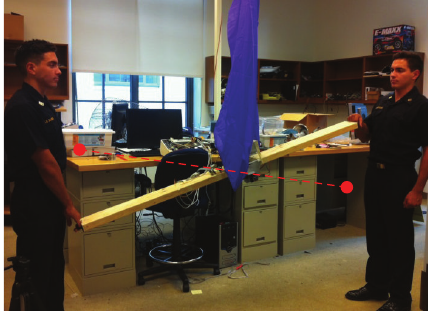
Figure 4: Experiment 2: two individuals move a board vertically. The cloth in the middle hangs from the ceiling, preventing the subjectsfromseeingeachother.Thedashedredlineisavisualization of an example target position and orientation.